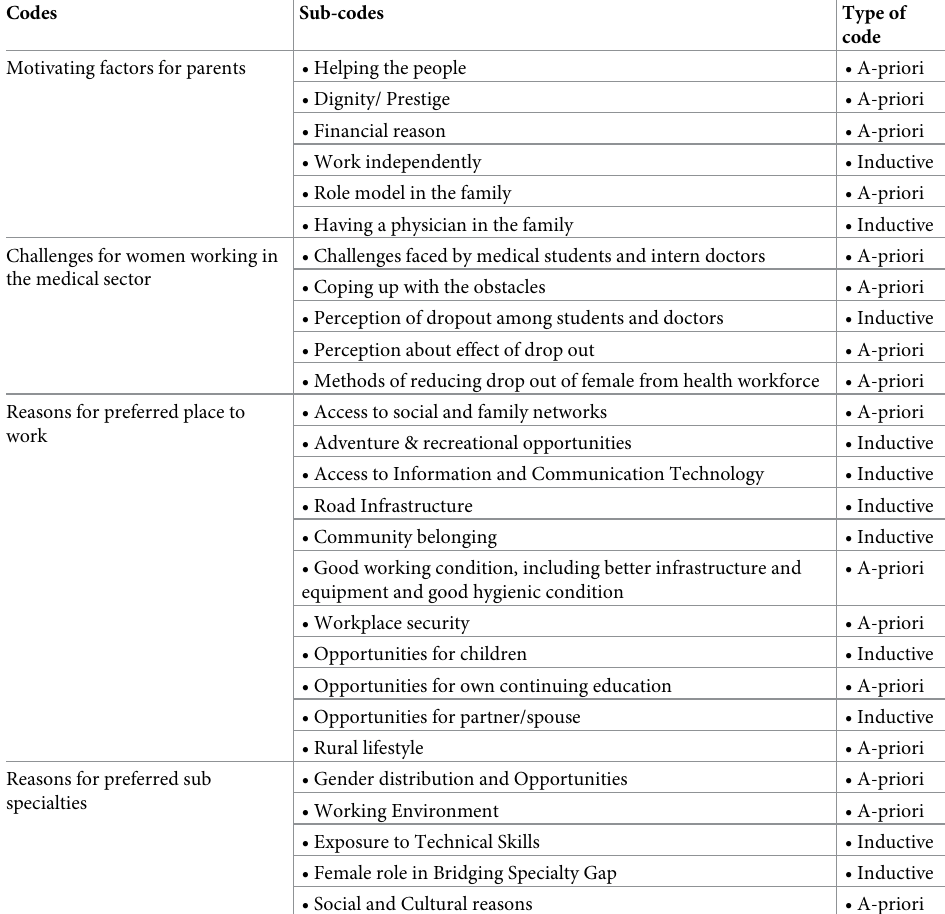
Table 2. Codes and sub-codes used for qualitative